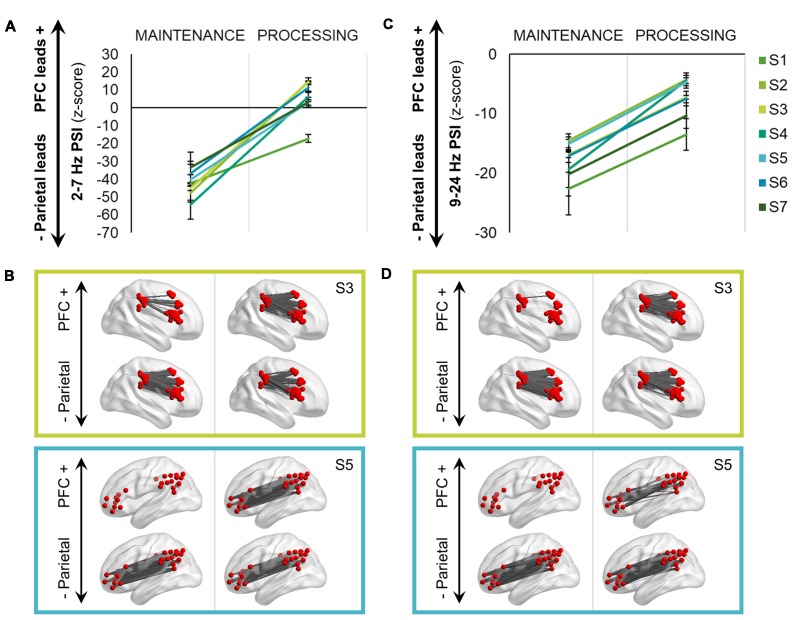
Bidirectional frontoparietal oscillations for information processing. (A) Delta-theta (2–7 Hz) phase slope index (PSI) shifted from a unidirectional, parietal-led network during maintenance to a bidirectional, frontoparietal network during the processing interval (p < 8 × 10−306). Data are represented as mean ± SEM per subject across all trials; positive values indicate that the prefrontal cortex (PFC) leads the parietal cortex and negative values indicate that the parietal cortex leads the PFC. S, subject. (B) Topographical representations of the PSI data depicted in (A) in two subjects. PSI is masked per electrode pair, with significant PFC leads in the top row (z > 1.96, p < 0.05) and parietal leads (z < −1.96, p < 0.05) in the bottom row. S3 was implanted subdurally in the right hemisphere and S5 in the left hemisphere. (C) Equivalent to (A): alpha-beta (9–24 Hz) PSI shifted from a unidirectional, parietal-led network during maintenance to a bidirectional, but still net parietal-led network during the processing interval (p = 0). (D) Equivalent to (B): topographical representations of the PSI data depicted in (C) in two subjects.